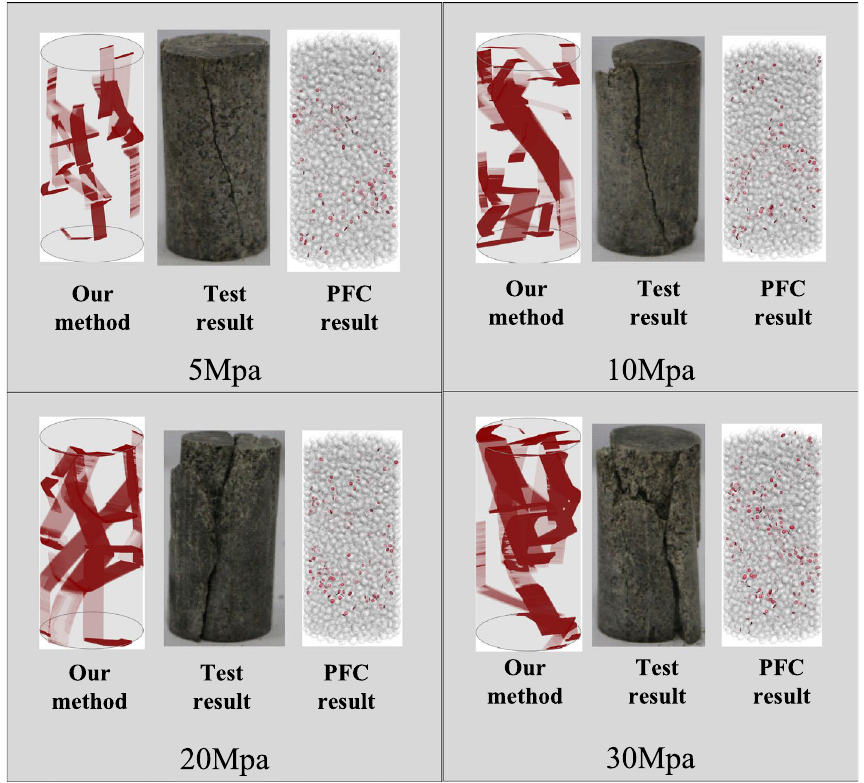
Figure 9. Comparison of our simulation result with the experimental test results and PFC3D results at peak stress